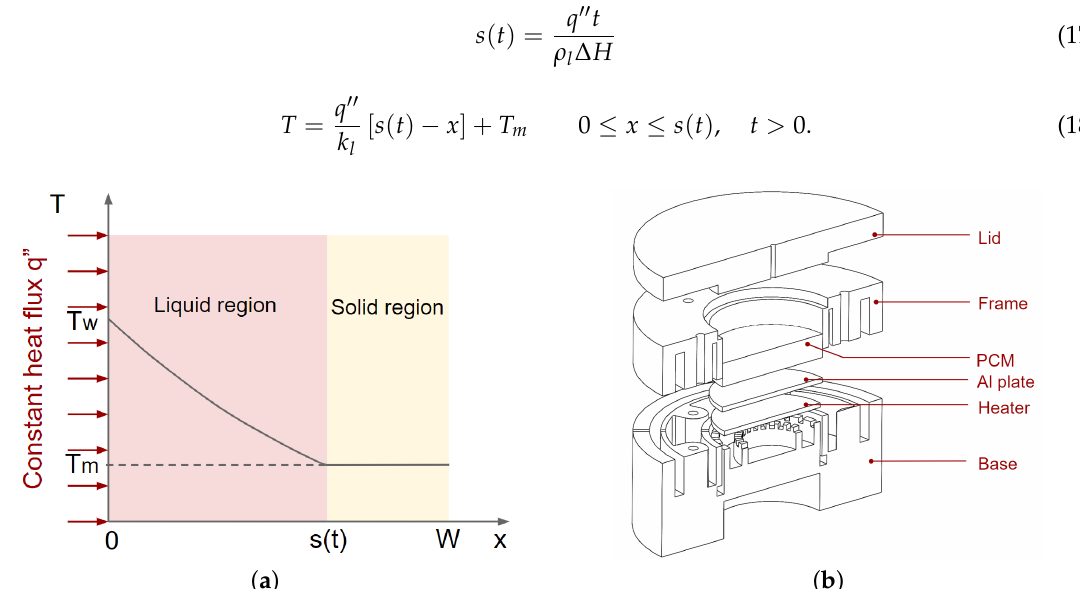
Figure 5. ( a ) Schematics of the 1D single-phase melting problem under constant heat flux (CHF) condition; ( b ) Cross-sectional view of the schematic of the experimental setup. Adapted from